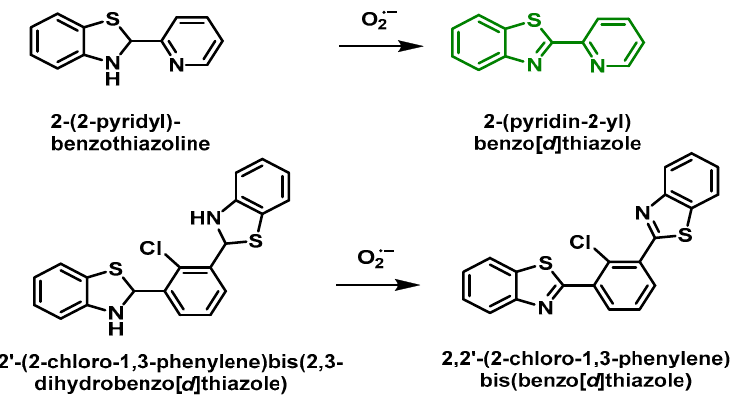
Figure 63. Response mechanism of the 2-(2-pyridyl)-benzothiazoline and 2,2 ′ -(2-chloro-1,3- phenylene) bis(2,3-dihydrobenzo [d] thiazole) probe to O 2•– .